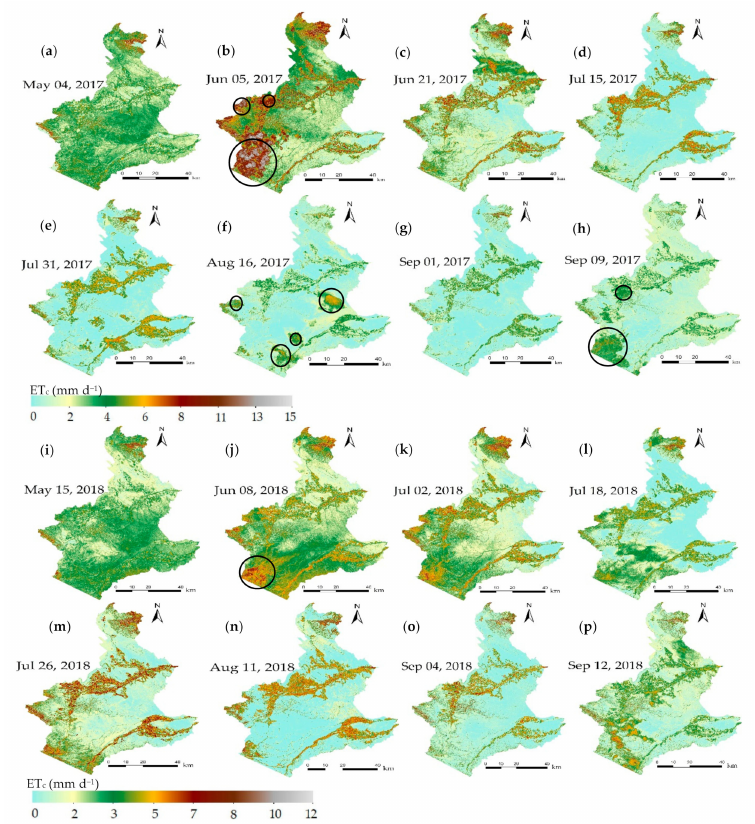
Figure 9. Spatio-temporal distribution of METRIC estimated daily Evapotranspiration (ETc, mm d − 1 ) during 2017 and 2018 growing season. ( a ) 4 May 2017, ( b ) 5 June 2017, ( c ) 21 June 2017, ( d ) 15 July 2017, ( e ) 31 July 2017, ( f ) 16 August 2017, ( g ) 1 September 2017, ( h ) 9 September 2017, ( i ) 15 May 2018, ( j ) 8 June 2018, ( k ) 2 July 2018, ( l ) 18 July 2018, ( m ) 26 July 2018, ( n ) 11 August 2018, ( o ) 4 September 2018, and ( p ) 12 September 2018. The Black circled portion in some images represent the cloud